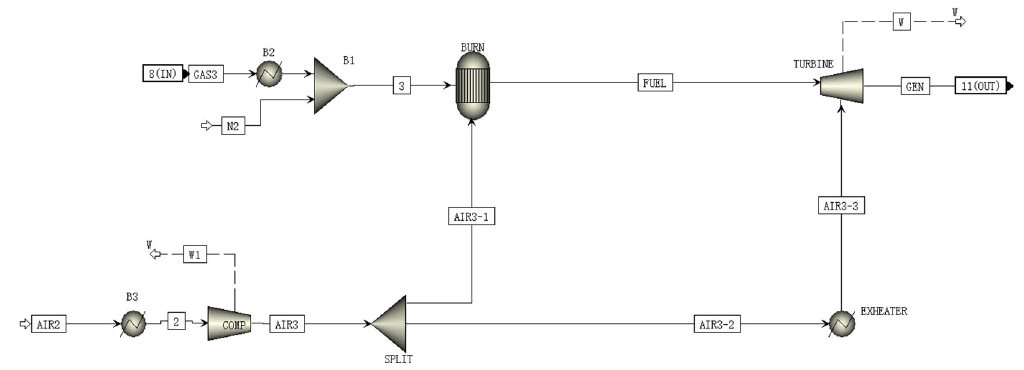
Figure 5. A schematic of the TURB module flowsheet.